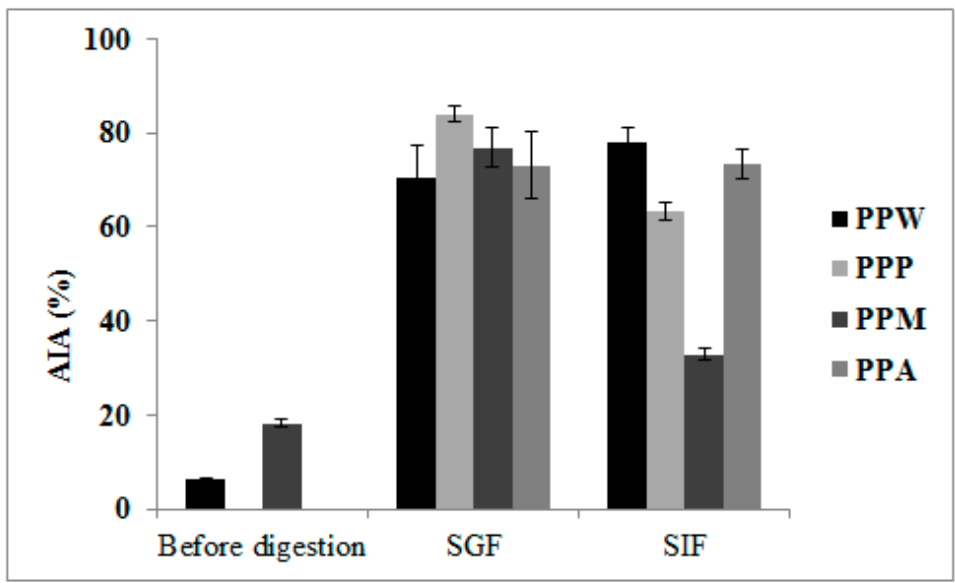
Figure 2. Anti-inflammatory activity of peach encapsulates.